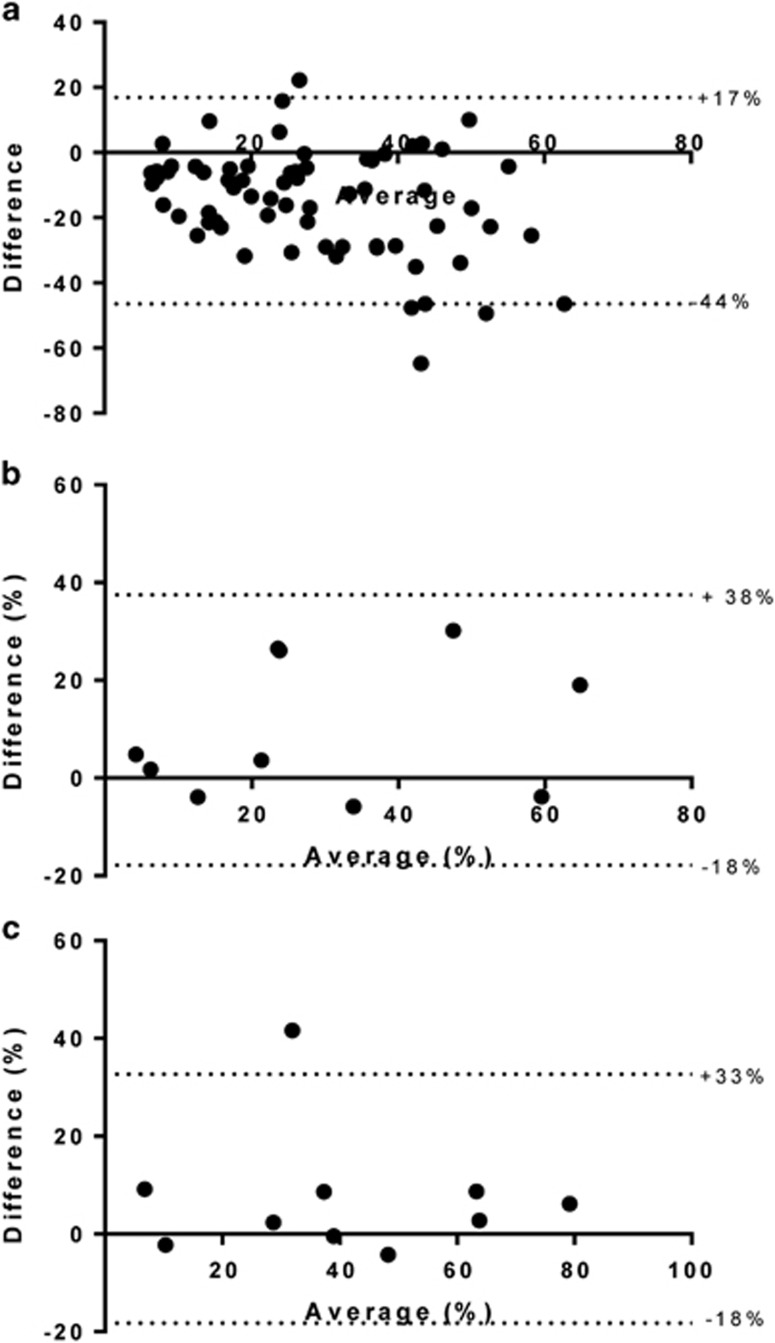
Comparison of different slide preparation and tumor-sampling techniques. Each point shows the difference between techniques plotted against the average of the two values. (a) Tissue microarray vs whole section from same tumor. Significant discrepancy was noted between tissue microarray and whole sections scores, with 95% limits of agreement lying at +17% and −44%. Endometrial cancer specimens were obtained from the same patient by blinded endometrial sampling performed immediately prior to surgery (pipelle) and after the uterus had been surgical removed (hysterectomy). (b) Whole slide scoring method. Significant variation between the two tumor-sampling techniques was noted using whole slide scoring (95% limits of agreement −18 to +38%). (c) Hot spot scoring method. In contrast, hot spot scoring appeared more consistent, with the exception of a single outlier.